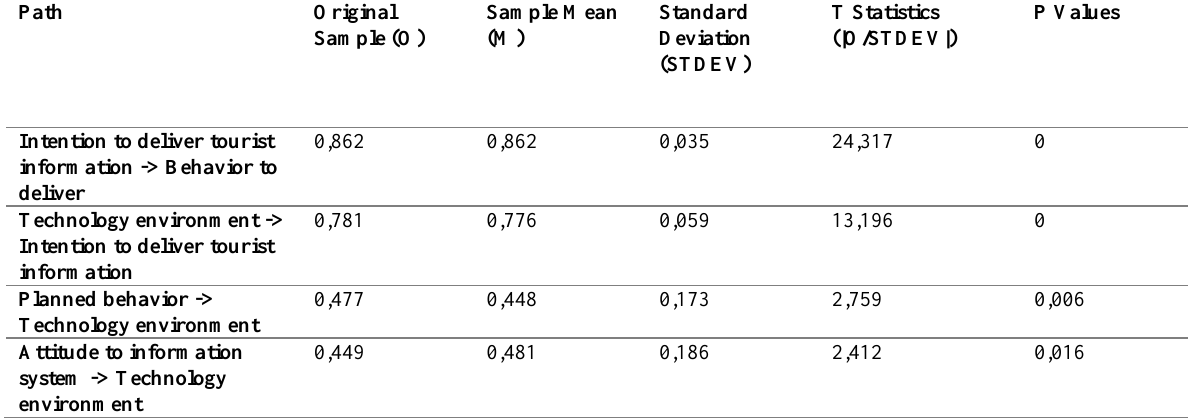
Table 2: Path Analysis and P-values of the research hypothesis- communities